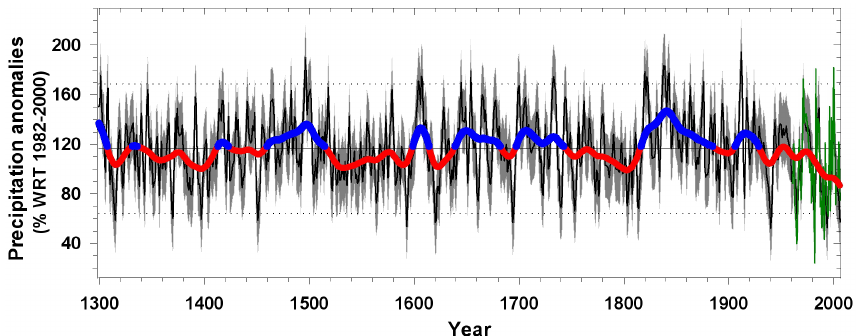
Fig. 4. The tree-ring reconstruction of annual (November–October) precipitation in the Altiplano region, Central Andes, for the period 1300–2006 (annual precipitation expressed as percentages (%) of the 1982–2000 instrumental precipitation mean). The shaded area denotes the 1 ± root-mean-square error bars and the green line represents the instrumental record. To emphasize the low-frequency variations a 35-yr smoothing cubic spline designed to reduce 50% of the variance is shown in blue and red indicating wet and dry periods, respectively, with respect to the 1300–2006 mean. The dotted horizontal lines indicate ± 2 standard deviations.